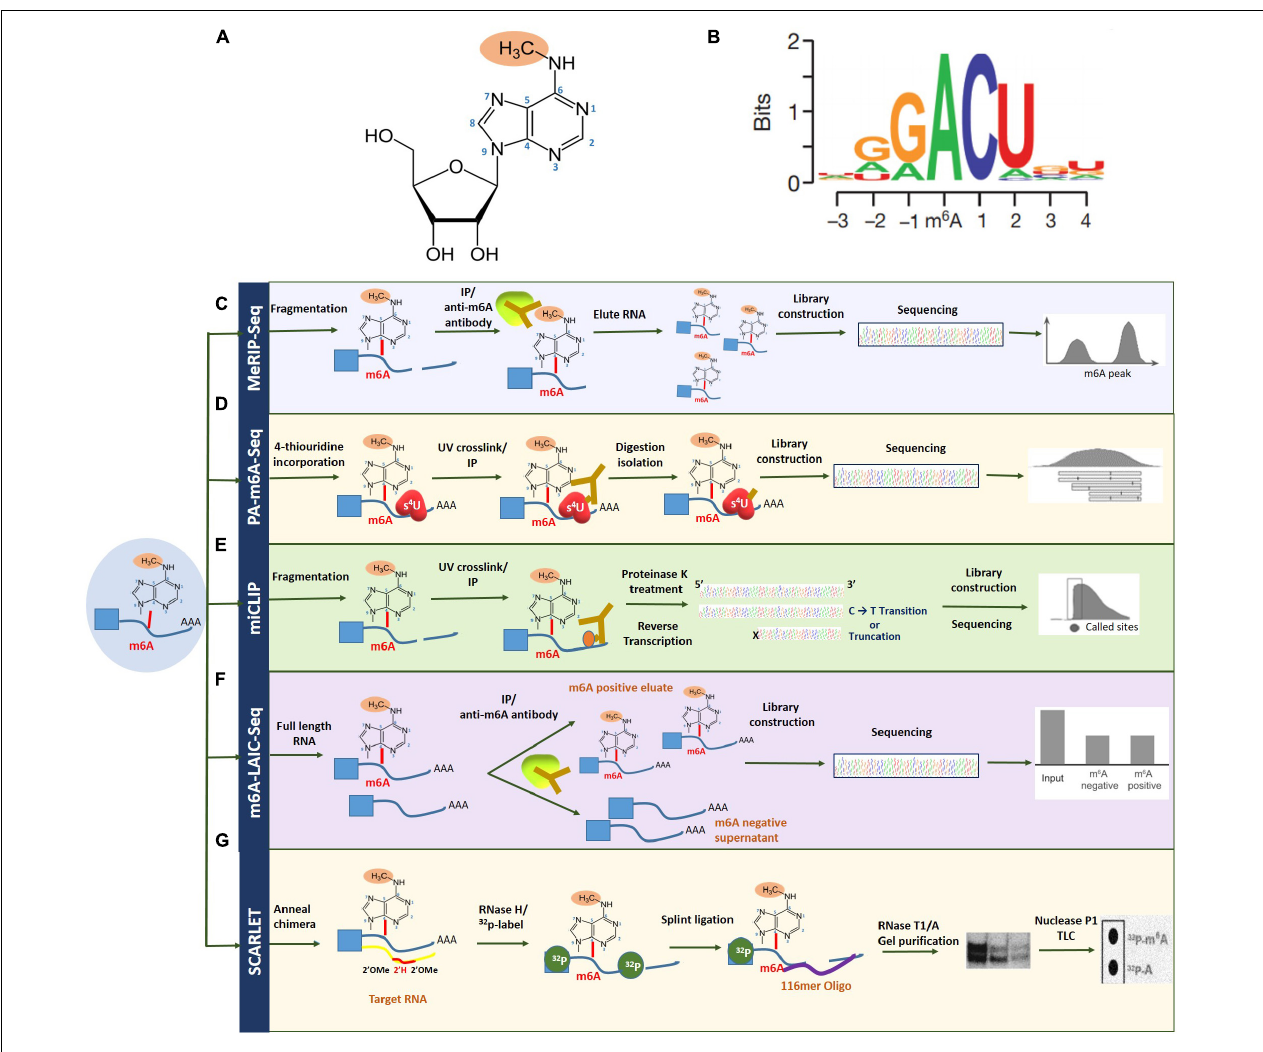
FIGURE 2 | Overview of m6A RNA methylation and m6A mapping technologies. (A) N 6 -methyladenosine refers to the addition of a methyl group to the nitrogenous base present at the sixth position of the adenine residue in the RNA. (B) Topological analysis has indicated that m6A methylation occurs mainly near the 3 (cid:48) -UTR region, on adenosine residues presenting in a consensus motif of RRm6ACH (R = G/A, H = A/C/U). Transcriptome-wide sequencing technologies for mapping m6A (C) , MeRIP-seq (D) , PA-m6A-seq (E) , miCLIP (F) , and m6A-LAIC-seq (G) SCARLET. Figure modified from Dominissini et al. (2012); Liu et al. (2013), and Li et al.